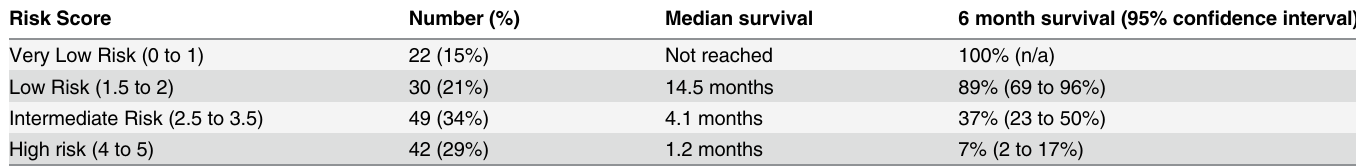
Table 5. Median and 6-month survival stratified by risk